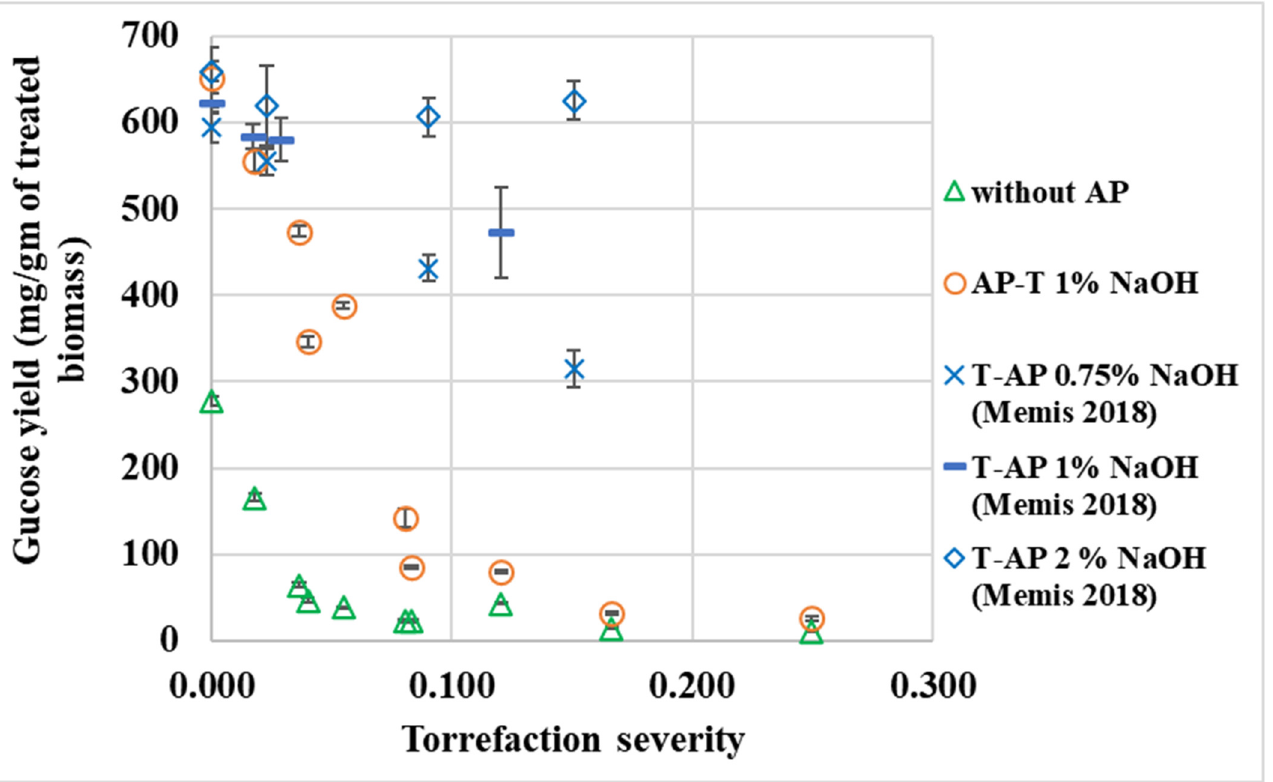
Figure 5. Glucose yield vs. Torrefaction Severity (T-AP = Torrefied then Alkaline Pretreated Wheat